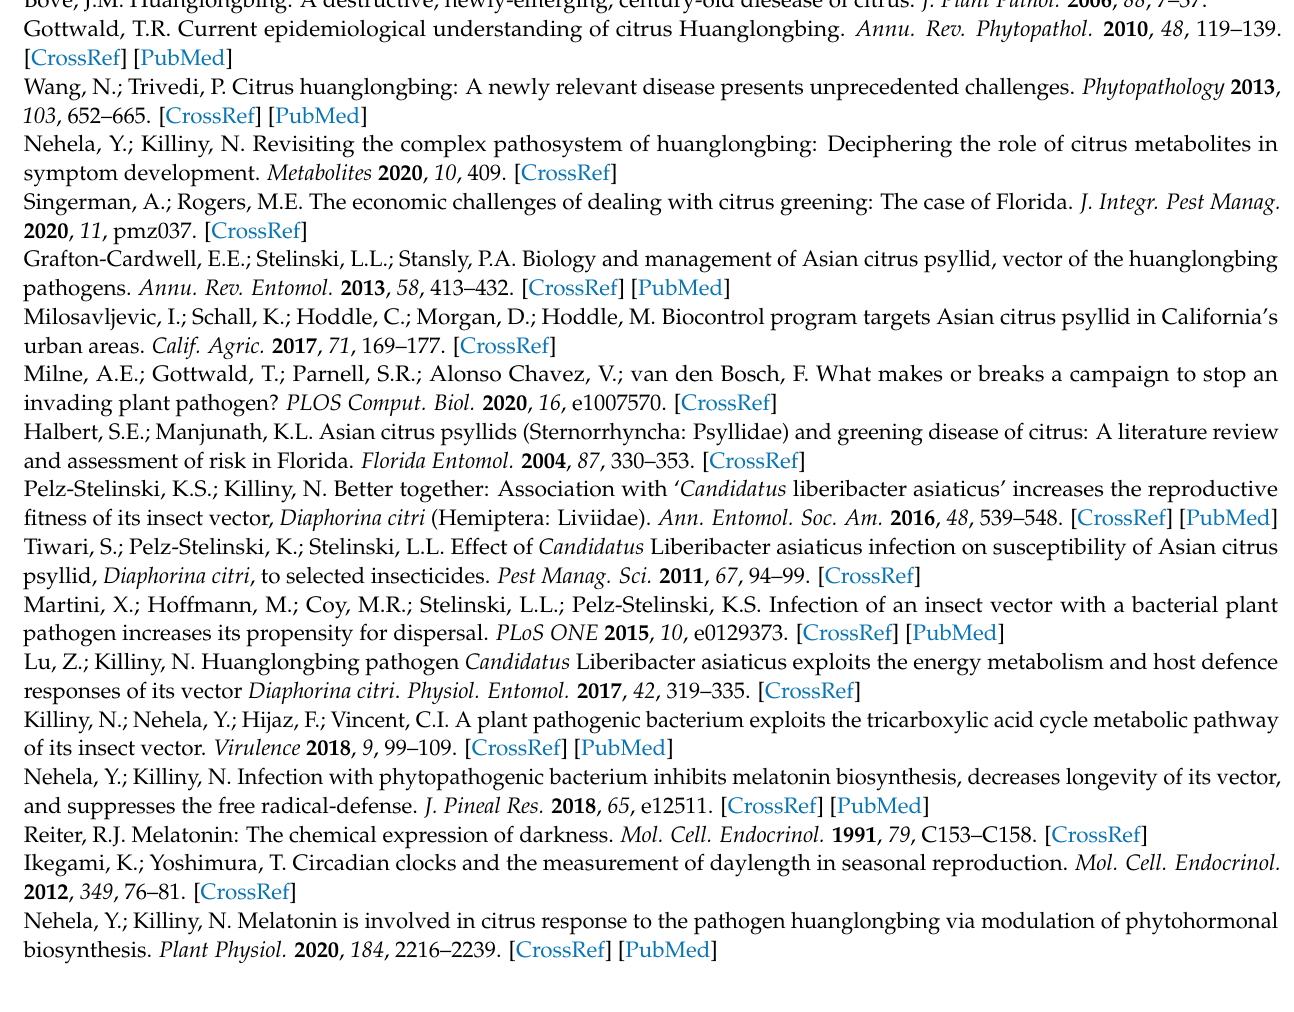
DcAANAT -1 from Diaphorina citri . Figure S8. Multiple AA sequence alignment of DcAANAT -2 from Diaphorina citri . Figure S9. Multiple nucleotide sequence alignment of DcAANAT -1 from Diaphorina citri . Figure S10. Multiple nucleotide sequence alignment of DcAANAT -2 from Diaphorina citri . Figure S11. Multiple AA sequence alignment of DcASMT from Diaphorina citri . Figure S12. Multiple nucleotide sequence alignment of DcASMT from Diaphorina citri